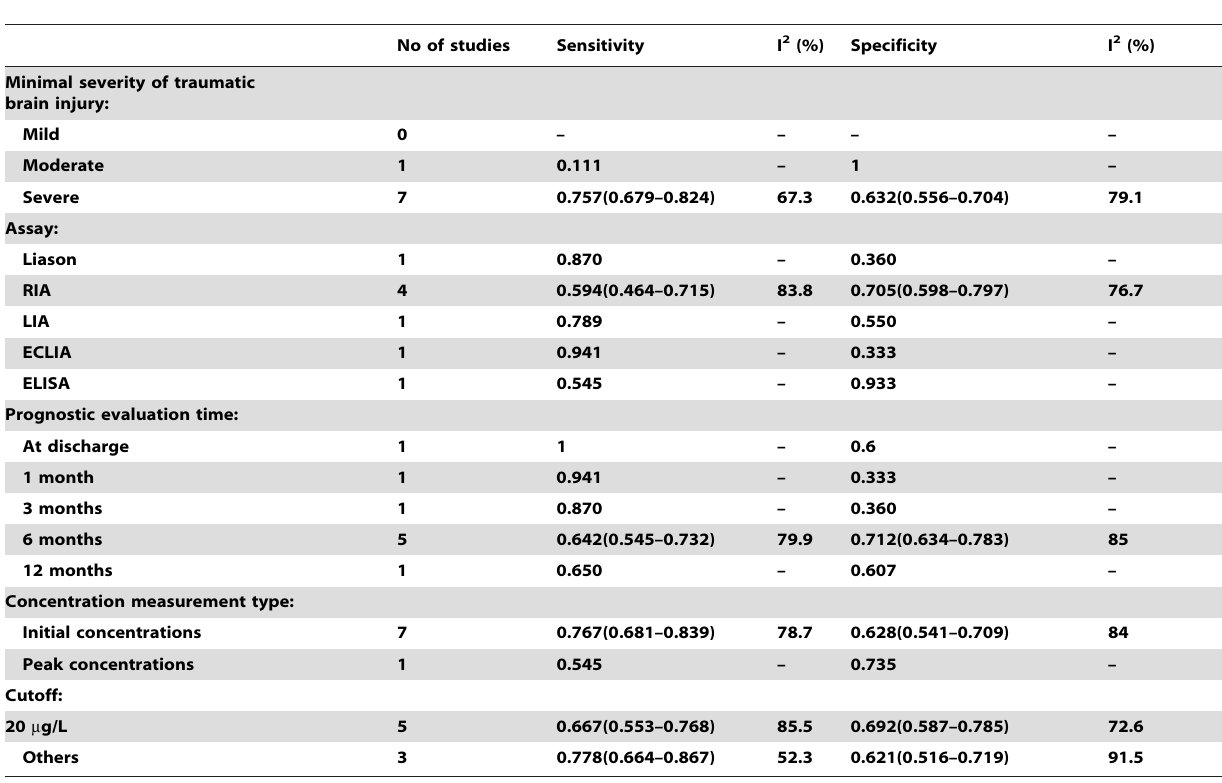
Table 5. Sensitivity analyses for the sensitivity and specificity of NSE concentrations to predict unfavourable outcome in patients with traumatic brain